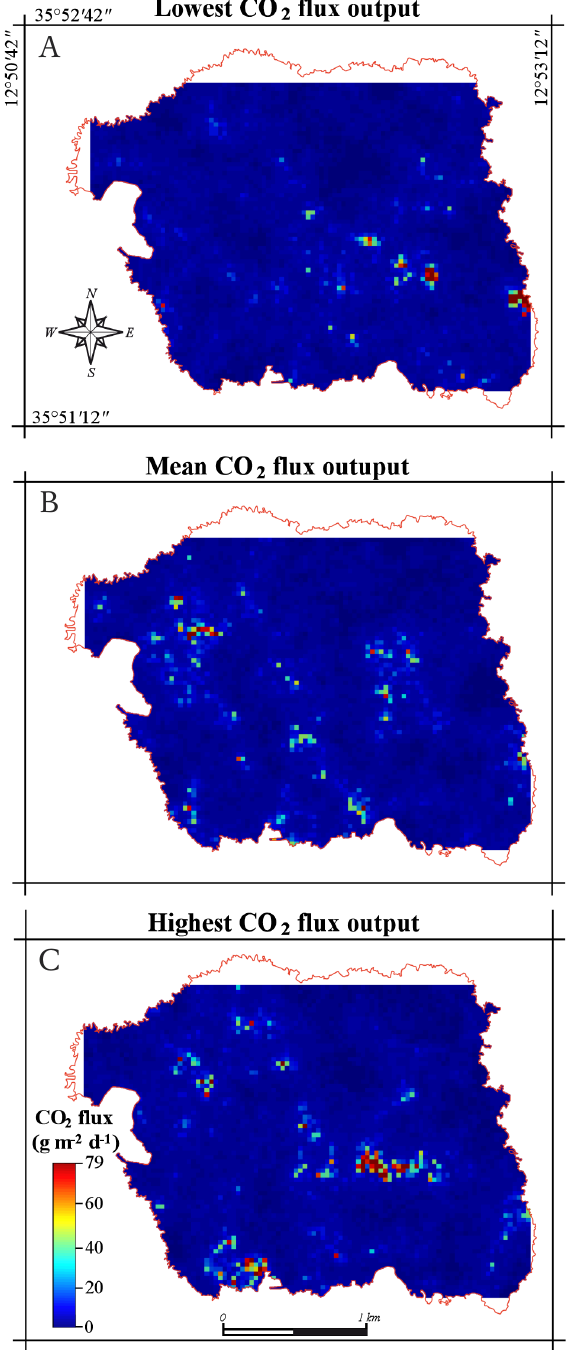
flux. From the top to the bottom, the Figure 5. Maps of soil CO 2 map relative to the realization giving the lowest value of the soil flux output, the map relative to the realization giving the mean CO 2 value of the soil CO flux output, and the map relative to the real- 2 ization giving the highest value of the soil CO flux 2